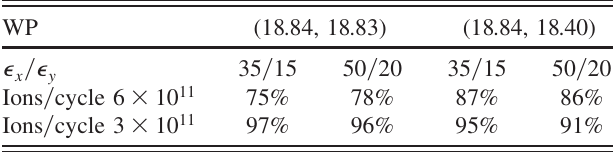
TABLE I. Beam survival averaged over a full SIS100 cycle for two different working points in tune